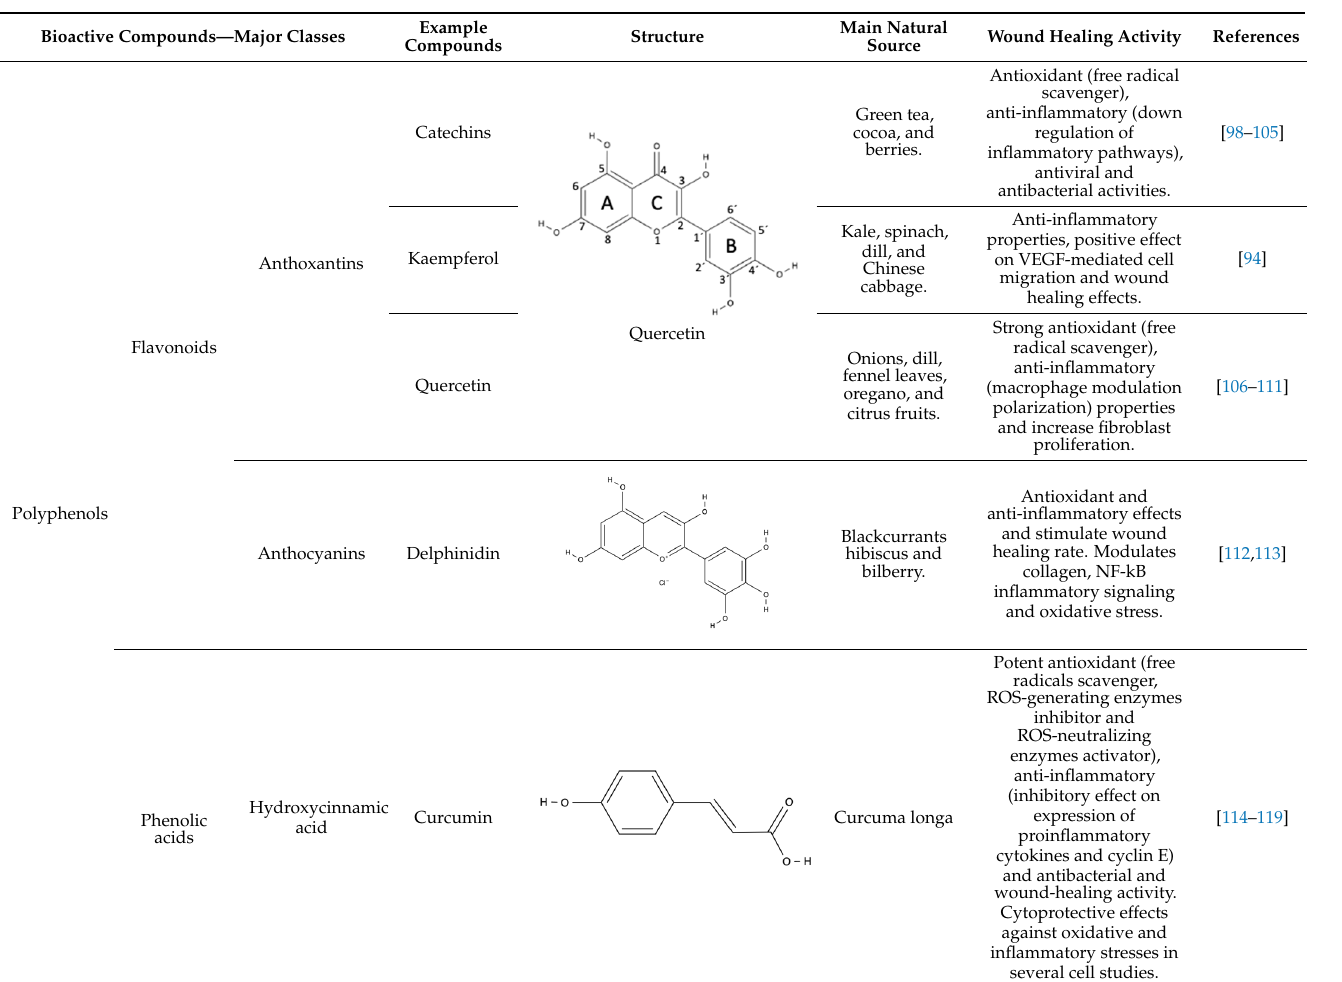
Table 1. Major classes of natural bioactive compounds, structure, main sources, and their therapeutic targets for wound-healing activity.